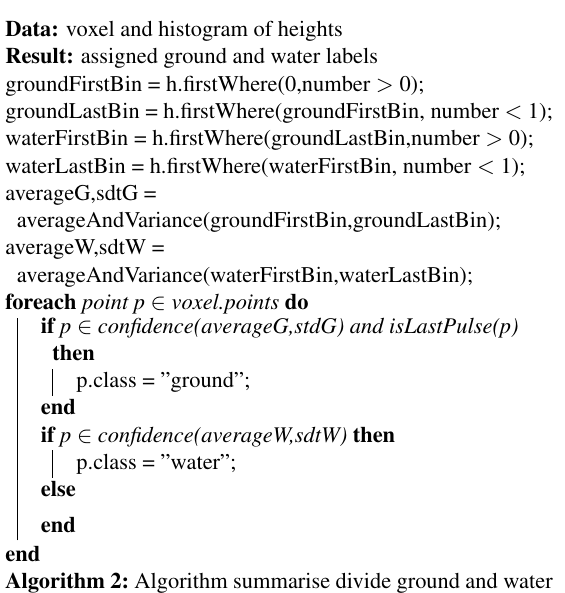
Algorithm 2: Algorithm summarise divide ground and